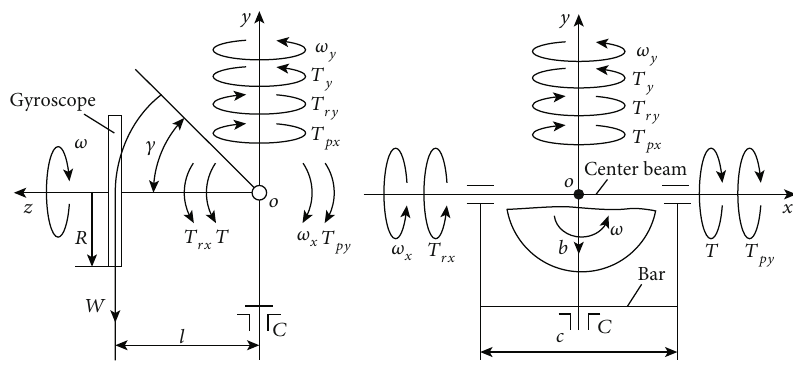
Figure 1: The torques and motions acting on the gyroscope with one side